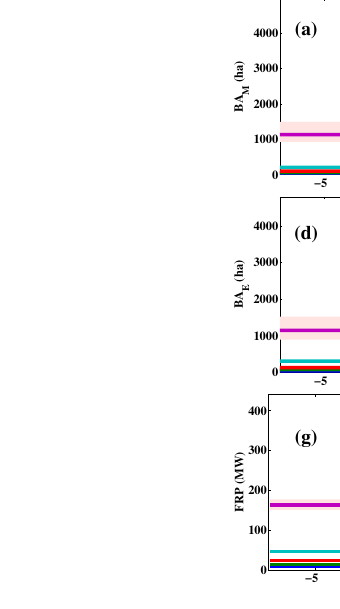
Figure 1. Evolution of 5th (blue), 25th (green), 50th (red), 75th (cyan) and 95th (purple) quantiles of BA (data set BA M and BA E ) and FRP (FRP data set) with (cid:49)T 2 , WS 10 and (cid:49)N precip . Top row corresponds to BA M , middle to BA E and bottom to FRP. The red shaded area corresponds to 90% confidence intervals for the 95th